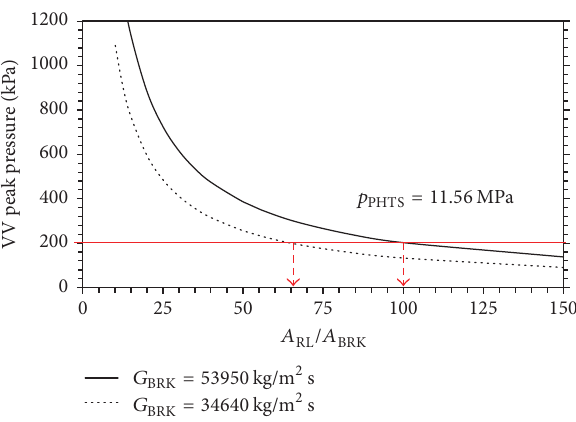
Figure 11: VV and ST pressures (larger